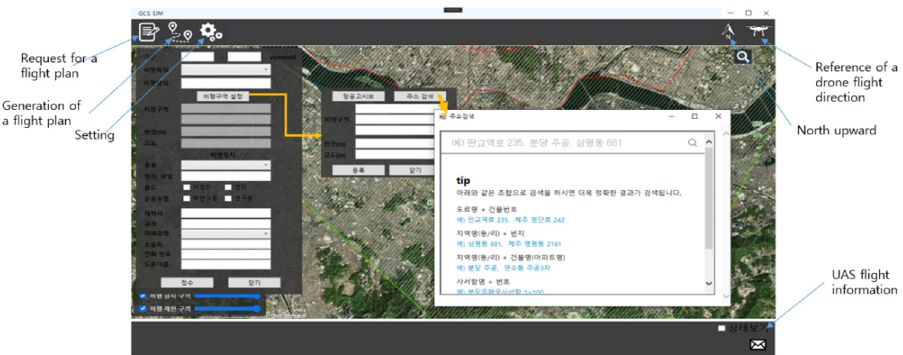
Figure 2. Graphic UI (User Interface)—GCS (Ground Control Stations).